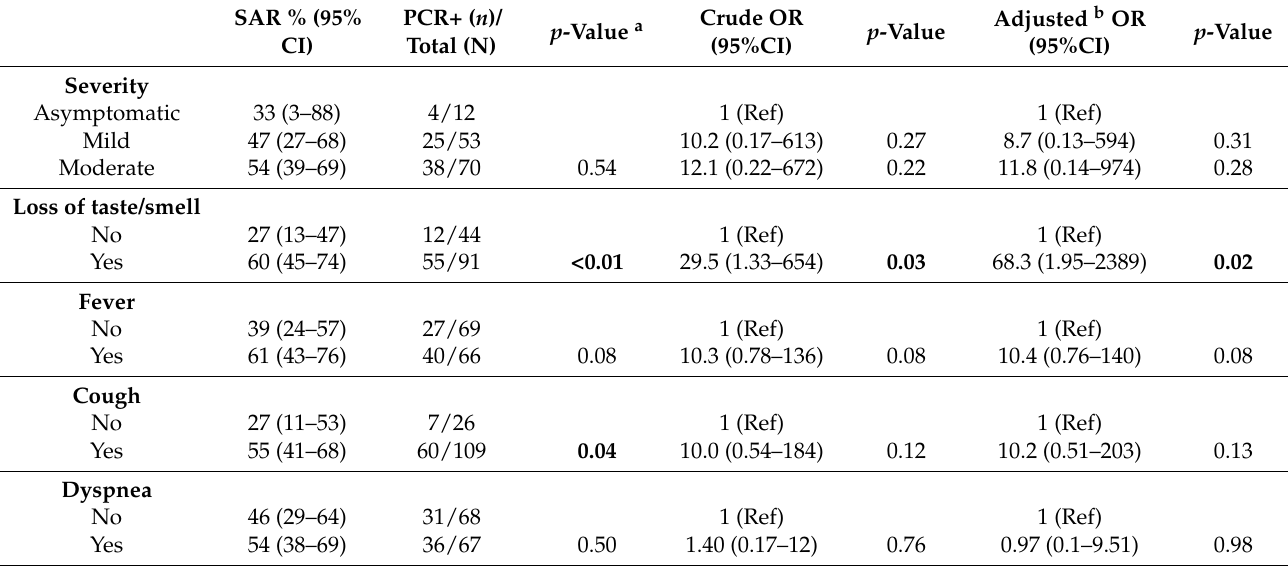
Table 4. Secondary attack rates (SAR) and odds ratios (OR) for secondary infection for all household contacts (N = 135) according to clinical severity and symptoms of primary